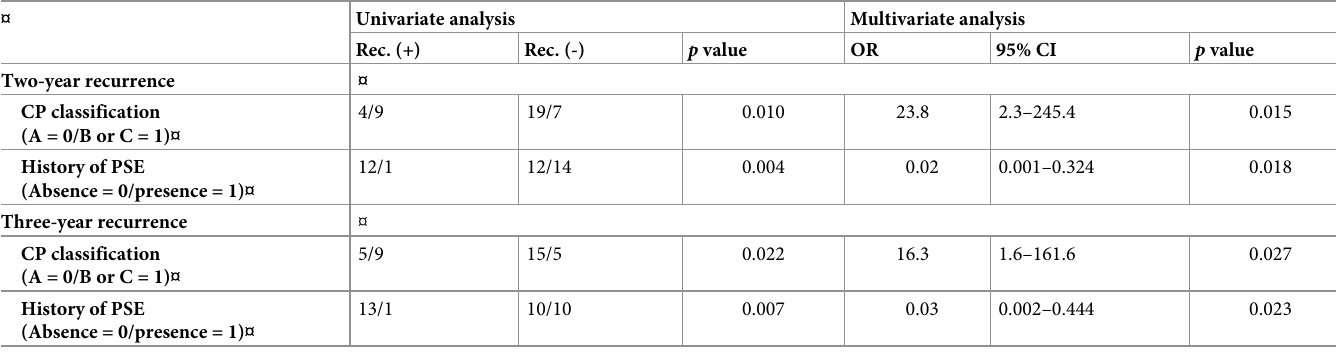
Table 2. Univariate and multivariate analyses identifying factors that predict the recurrence of esophageal varices after endoscopic treatment.